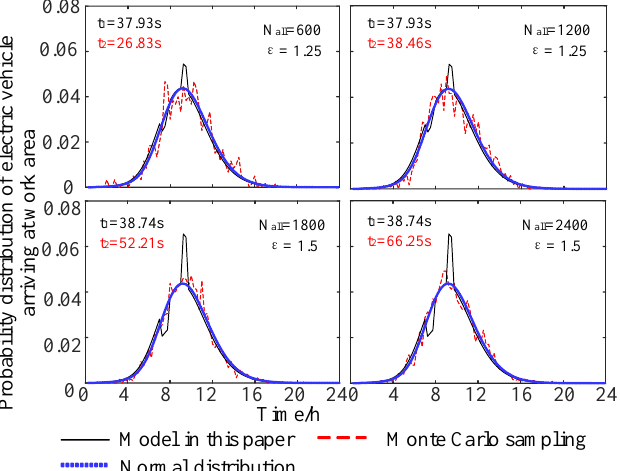
Figure 5. Distribution of the time EVs reach the working area in the H – W – H travel chain.